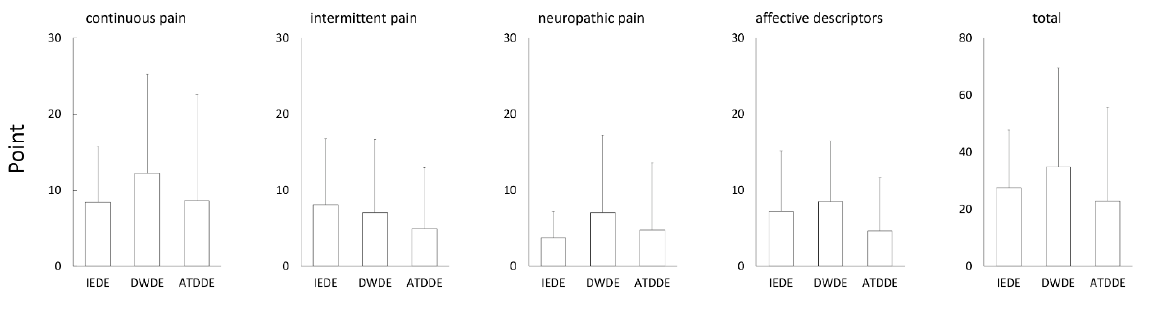
Figure 2. Eye pain evaluated by Short-Form McGill Pain Questionnaire 2. The mean value of the point for each pain subscale and total pain was plotted for each DE subtype, and the standard deviation is shown as a vertical bar. The Tukey-Kramer HSD test was used for statistical analysis, and a p -value of <0.05 was considered statistically significant.